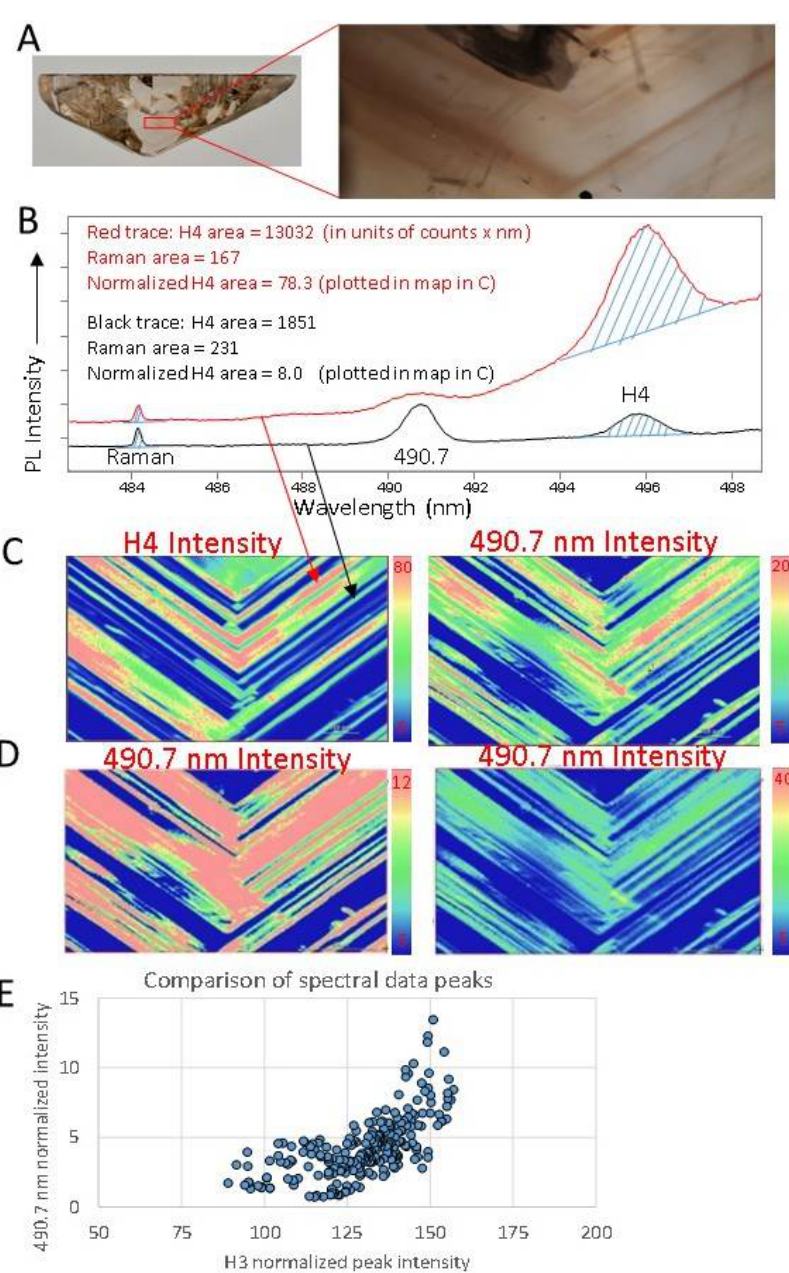
Figure 3. ( A ) Here is an example of a type Ia natural diamond with pronounced brown graining. ( B ) A few individual spectra along with some example calculations are shown as illustration of the internal, baseline-corrected calculations occurring for the dozens of possible variables across the thousands of collected spectra. ( C ) These false color PL maps were assembled from data collected with 455 nm excitation with the diamond submerged in liquid nitrogen. The PL mapping data are composed of ~26,000 individual spectra taken with a 10 µm pixel size in 4½ min. They show the normalized peak intensity for the H4 defect at 495.9 nm and the PL feature at 490.7 nm. ( D ) For the PL map shown in Figure 3C, right, the color ranges are adjusted to opposite extremes to illustrate the differences in data representation that can be seen from adjusting the color limits. ( E ) Additional analysis of the spectral data is possible by exporting the calculated values into external programming, such as plotting the intensities of various spectral features within a spreadsheet software in which each datapoint originates from a different spectrum. The data shown here for H3 and the 490.7 nm defect are for illustration only; no correlation can be concluded based on results from a single sample.